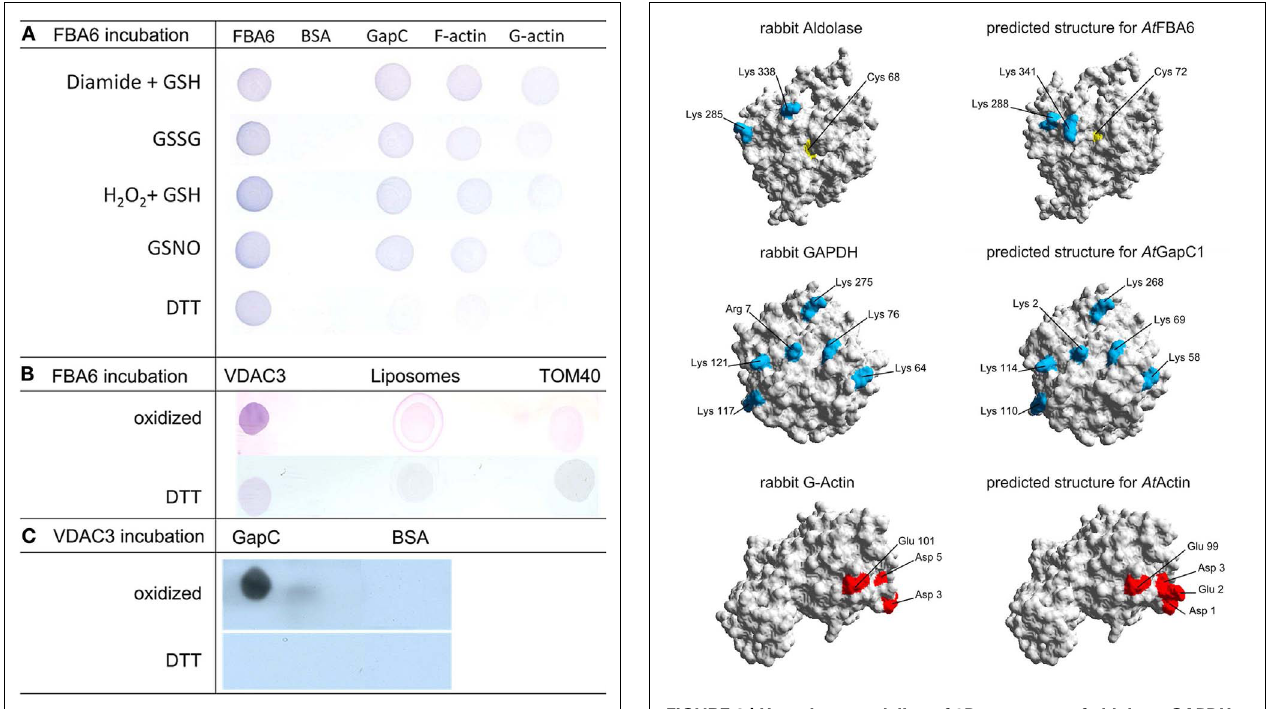
FIGURE 7 |Analysis redox-dependent binding of aldolase to GAPDH, actin andVDAC3 by FarWestern blotting. (A) Aldolase (FBA6; At2g36460), GAPDH (GapC1; At3g04120), G-actin, rabbit F-actin, and bovine serum albumin (BSA) as negative control (2 µ g each) were applied onto a nitrocellulose membrane, overlaid with 100 µ g/ml aldolase in the presence of 10mM DTT, 0.1mM GSNO, 5mM GSSG, 1mM diamide plus, 1mM GSH, or 0.5mM H 2 O 2 plus 0.5mM GSH, and probed with polyclonal antibody against maize aldolase as described in Section Experimental Procedures. (B) VDAC3 (At5g15090) reconstituted into liposomes was applied onto a nitrocellulose membrane, overlaid with 100 µ g/ml aldolase in the presence of 10mM DTT and without reductant (oxidized). Empty liposomes andTOM40 were used as controls, immunological detection of